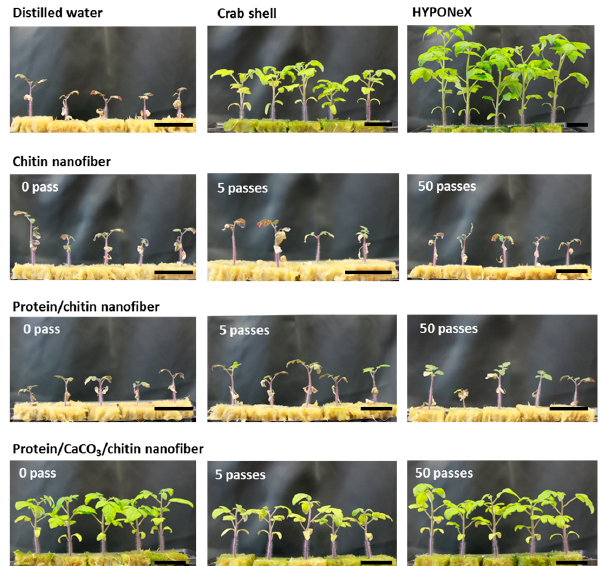
Figure 5. Tomato plants grown hydroponically with nanofibers. Tomato plants were treated with chitin nanofiber, protein/chitin nanofiber, and protein/CaCO 3 /chitin nanofiber at a final concentration of chitin 0.01%. The series of nanofibers were prepared with high pressure water jet treatment with 0, 5, and 50 passes. The photo was taken after the fifth nanofiber treatment. Distilled water was administered as a negative control and commercial nutrition (HYPONeX) as a positive control. Roughly-crushed crab shell powder was treated as a control. The scale bar length is 36 mm. Table 1. The effect of protein/CaCO 3 /chitin nanofibers on the growth of tomato plants. Day after Number of Number of Stem Diameter Plant Height Treatment Treatment Passes Leaves (mm)